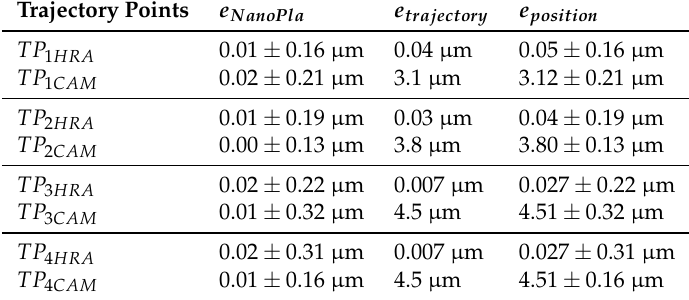
Table 5. NanoPla positioning system errors ( e NanoPla ), trajectory errors ( e trajectory ) and total positioning errors ( e position ) at certain points of the trajectory (totally positive (TP)) defined by the HRA method and CAM